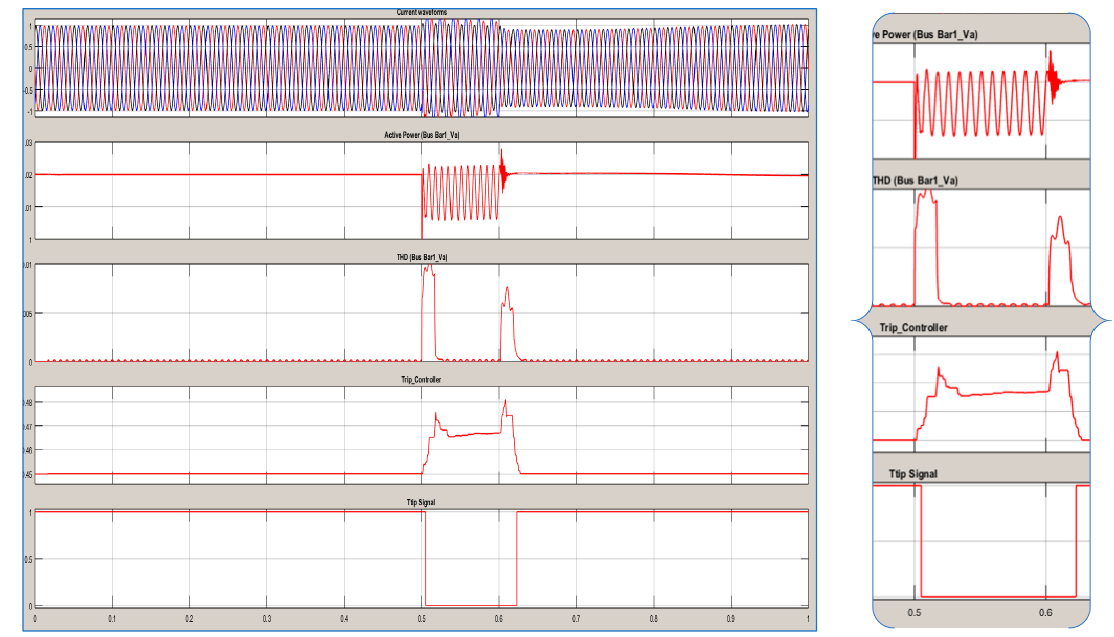
Figure 20. Double line (CA_G) fault current waveform.